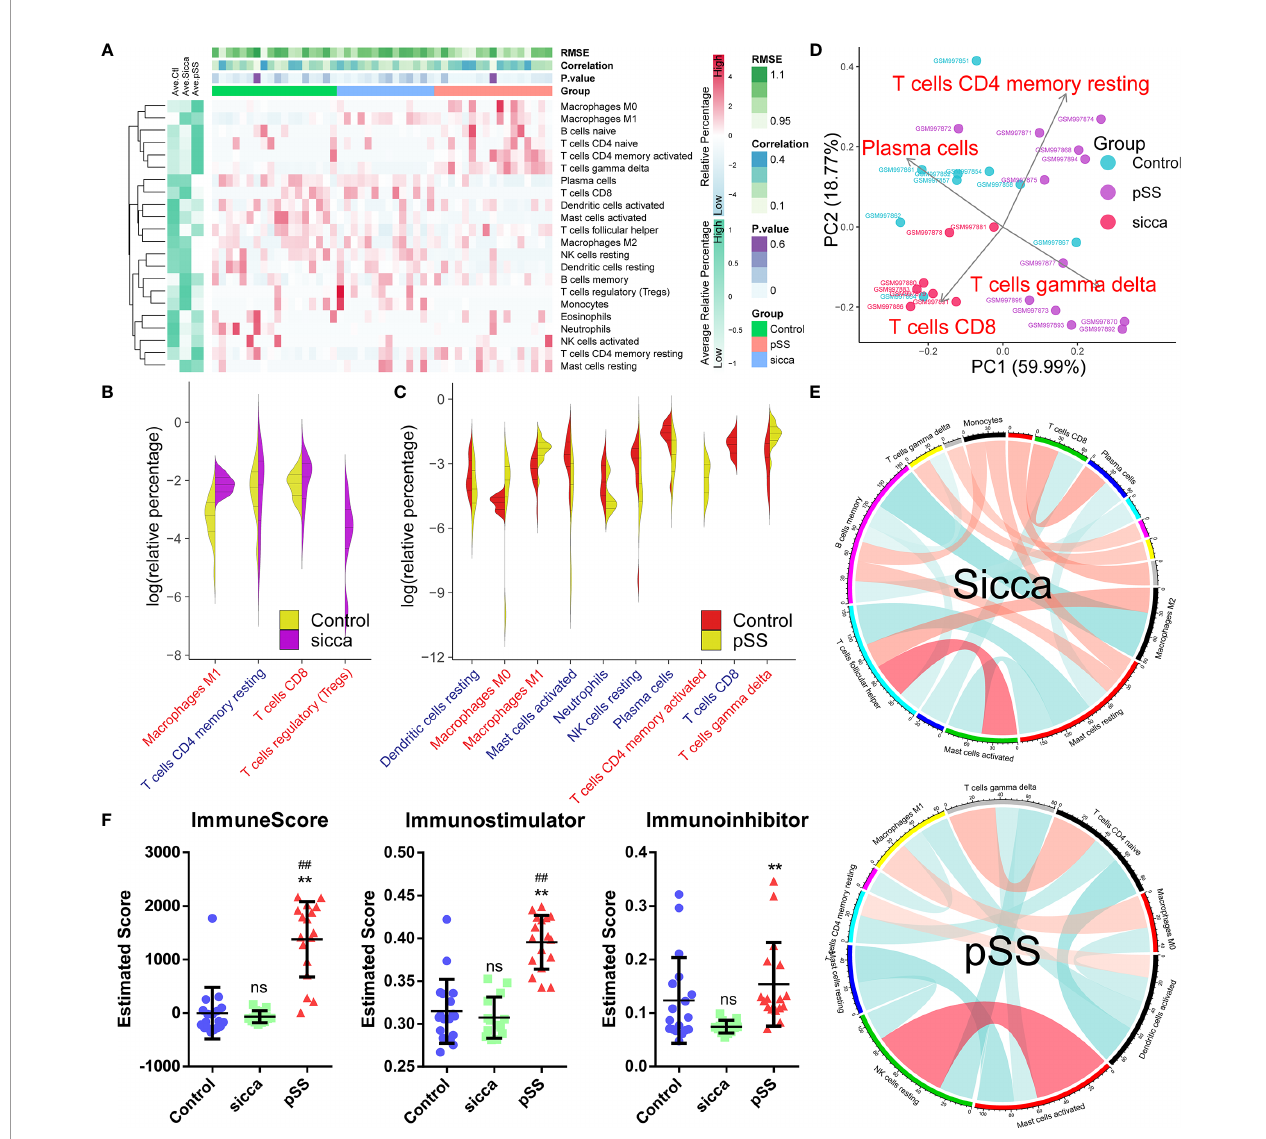
FIGURE 1 | Predicted disease-speci fi c immune in fi ltration patterns of pSS and “ Sicca ” . (A) The heatmap of the relative number of 22 types of immune cells estimated using the CIBERSORT algorithm and hierarchical clustering shows the landscape of the in fi ltration characteristics of pSS, “ Sicca ” , and control. RMSE, root mean squared error; correlation, Pearson correlation coef fi cient; P value; pSS, primary Sjögren syndrome. (B) Comparisons of in fi ltrating immune cell subpopulations of pSS versus control. Eleven subpopulations were identi fi ed as disease-relevant features of pSS. Blue, decreased subpopulation; red, increased subpopulation. (C) Comparisons of in fi ltrating immune cell subpopulations of “ Sicca ” versus control. Four subpopulations were identi fi ed as disease-relevant features of “ Sicca ” . (D) Principal component analysis (PCA) of 22 types of in fi ltrating immune cells. Four types of immune cells, including resting memory CD4 T-cells, CD8 T-cells, gamma delta T-cells, and plasma cells, were the principal elements contributing to the differences between the control, “ Sicca ” , and pSS. (E) Association network of in fi ltrating subpopulations estimated with the Pearson coef fi cient. Red, positive correlation; green, negative correlation. (F) Immune states of control, “ Sicca ” , and pSS estimated by ImmuneScore, Immunostimulator, and Immunoinhibitor using the ssGSEA algorithm. ##P < 0.01, pSS versus control; **P < 0.01, pSS versus “ Sicca ” ; ns, not signi fi